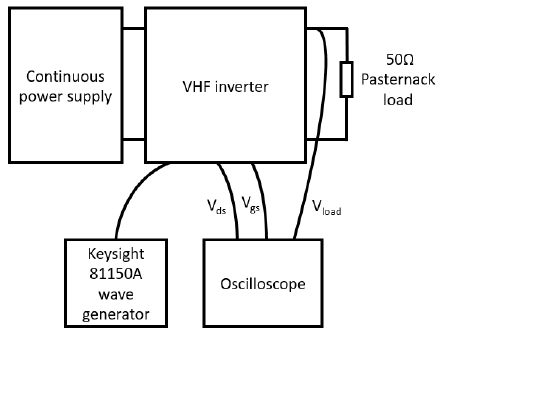
Figure 8. Diagram of the test bench ( a ), and L − Piezo inverter in operation ( b ).